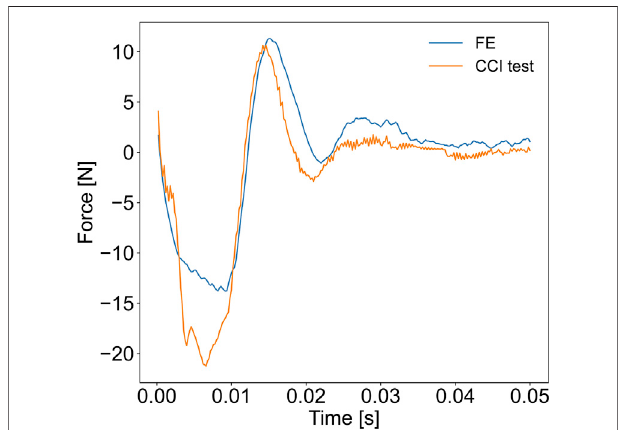
FIGURE 3 | Results of the validation of the FE porcine brain model. The reaction force exerted by the impacted brain on the probe during the CCI was measured experimentally and compared with the force-time history simulated with the FE